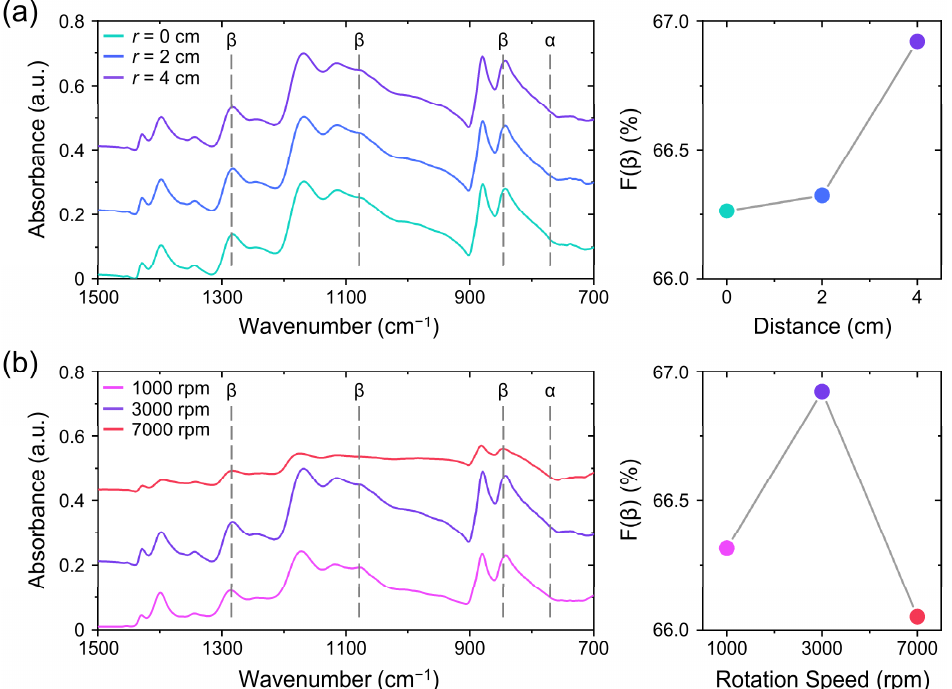
Figure 4. Fourier transform-infrared (FT-IR) absorbance spectra and the relative fraction of piezoelectric β-crystalline phase of spin-coated P(VDF-TrFE) film specimens obtained ( a ) at various distances from the center and ( b ) under different rotational speeds. In ( a , b ), characteristic absorbance bands were labeled for the α- and β-phases.